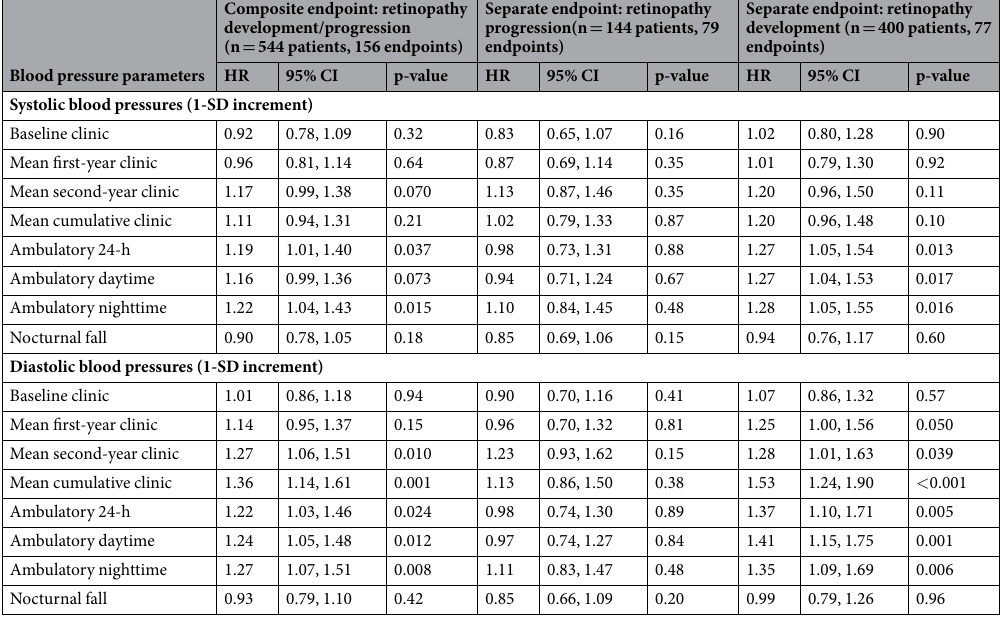
Table 3. Predictive value of several clinic and ambulatory blood pressure parameters measured at different time-intervals during follow-up for future development and/or progression of diabetic retinopathy (composite and separate endpoints). Models were adjusted for age, sex, diabetes duration, presence of retinopathy (for analyses of the composite development/progression of retinopathy), nephropathy and peripheral neuropathy at baseline, and their respective HbA 1c and LDL-cholesterol levels. Abbreviations: HR, hazard ratio; CI, confidence interval; SD, standard